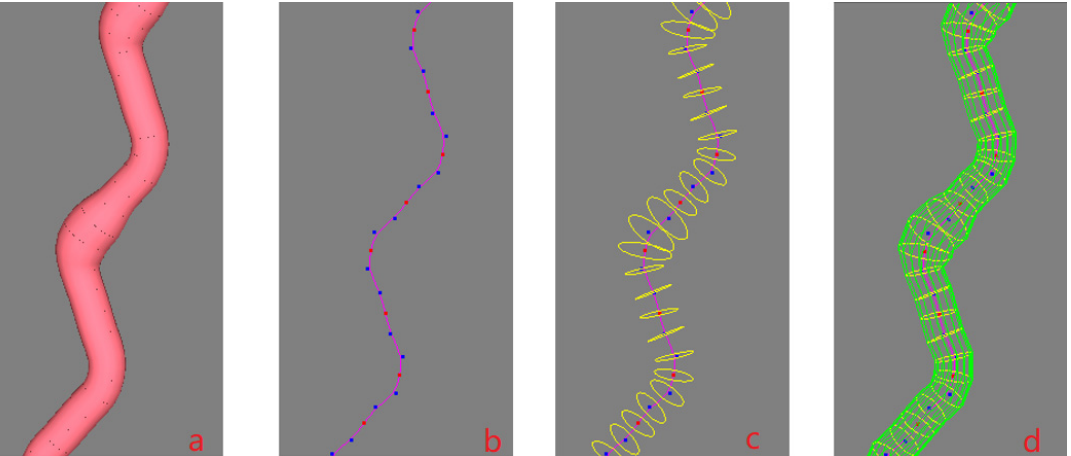
Figure 3. Design process of a 3D irregular yarn. ( a ) A solid 3D irregular yarn. ( b ) The control points of the cubic quasi-uniform B spline curve (red points: key points and control points, blue points: control points). ( c ) Cross-sections of the yarn. ( d ) Control grid of the B-spline surface for the 3D yarn.